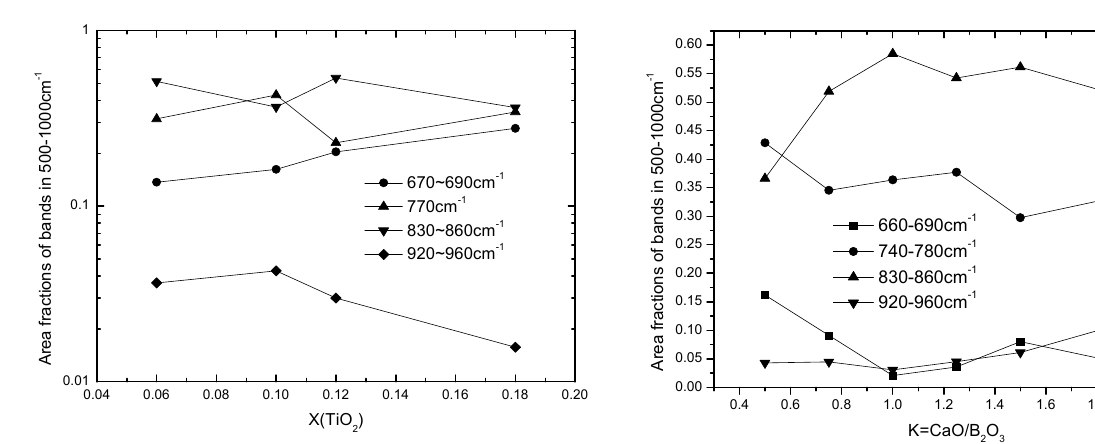
Figure 8. Area fractions of bands in 500–1000 cm (cid:3) 1 as functions of K D x (CaO) =x (B 2 O 3 /